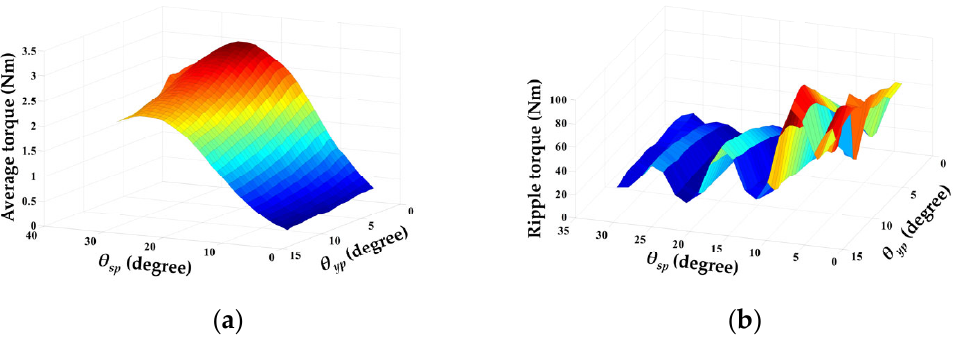
Figure 4. Influence of PM arcs on torque production for a multi ‐ tooth HE ‐ DSDPM: ( a ) average torque and ( b ) ripple torque.